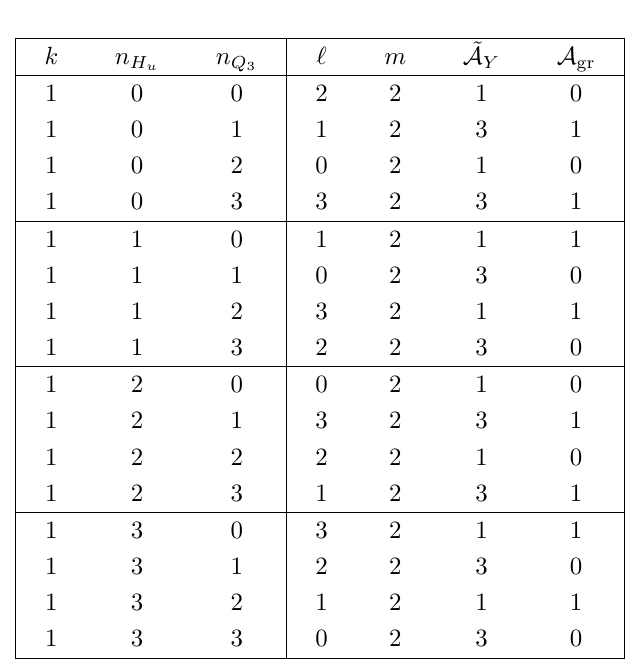
Table 1 . Values of ( ‘ , m , ~ A Y , A gr ) for k = 0 ( m = 1) with given n H are determined through eqs. (2.28) and (2.31), so that the hierarchy pattern eq. (2.25) is realized and the anomalies of Z F are vanishing in the SM non-abelian gauge groups. ~ A Y = A 4 the normalized anomaly of Z F in the U(1) Y gauge group. If n Y is a multiple of 4, the anomaly is 4 absent even for ~ A Y (cid:17) 2. We (cid:12)nd ‘ = 0 and 2 for A gr (cid:17) 0 modulo 2.